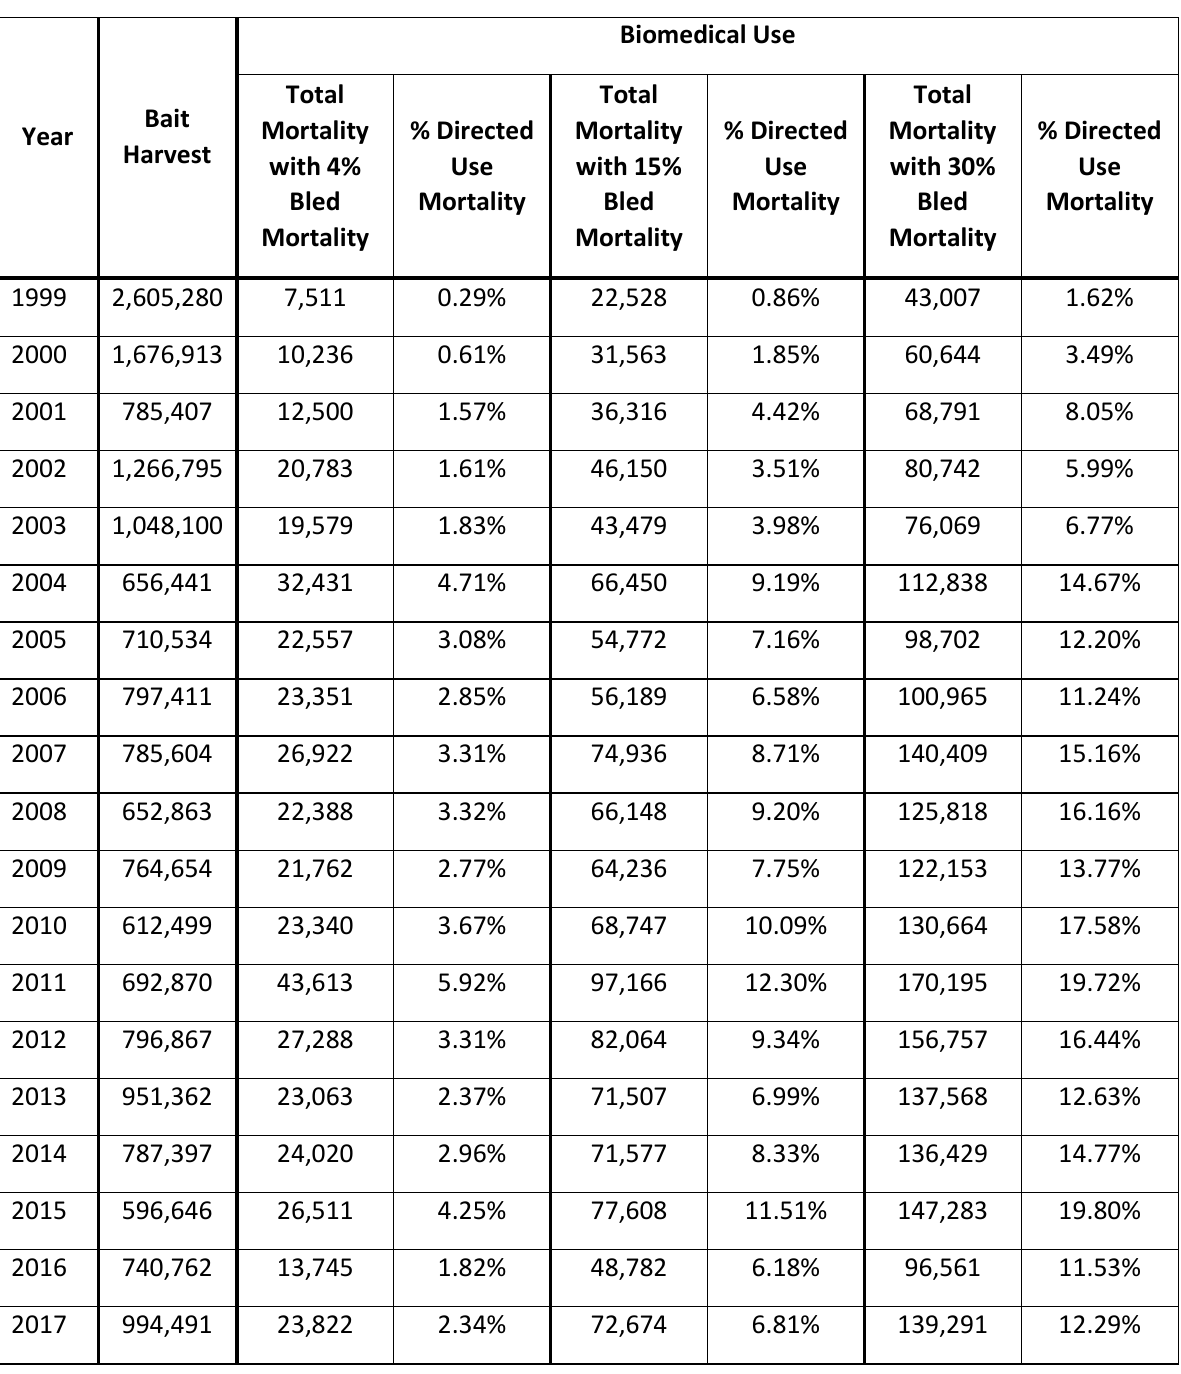
Table 27. Directed (bait and biomedical) use mortality by numbers of crabs using biomedical bleeding mortalities of 4%, 15%, and 30%. Biomedical mortalities are also shown as annual percentages of total directed use